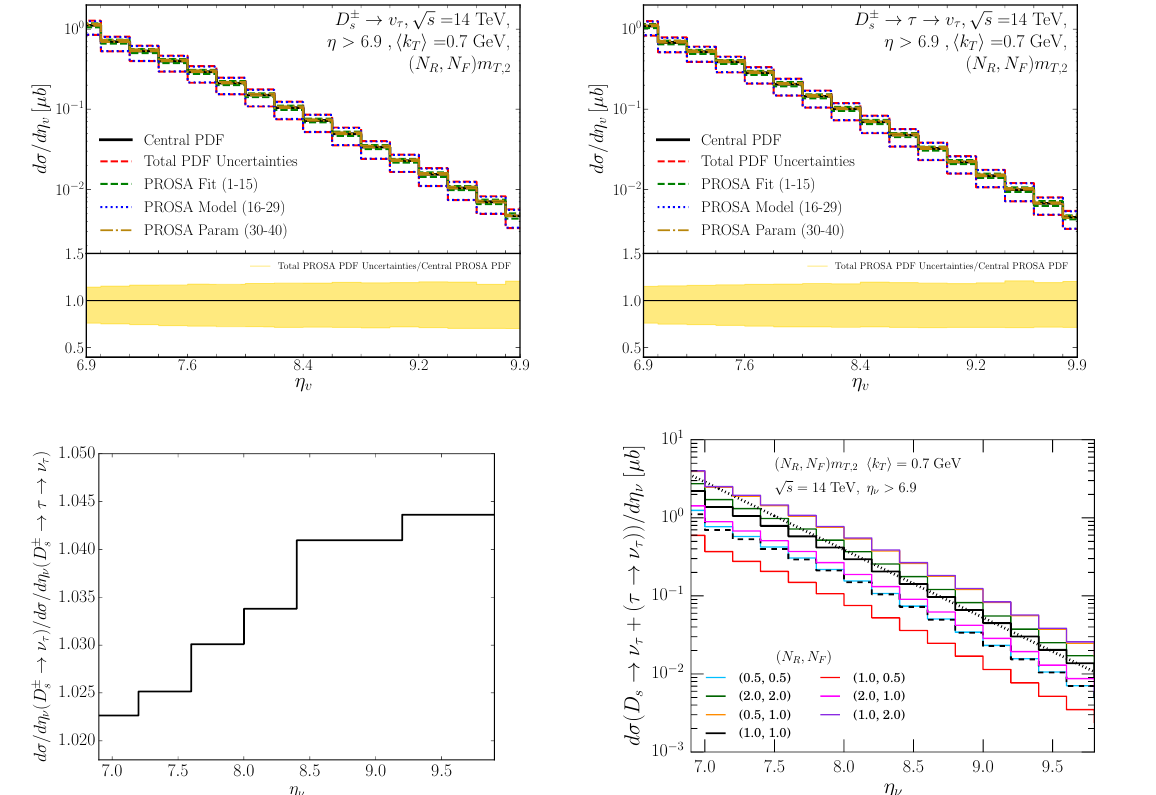
√ s = 14 TeV. The upper